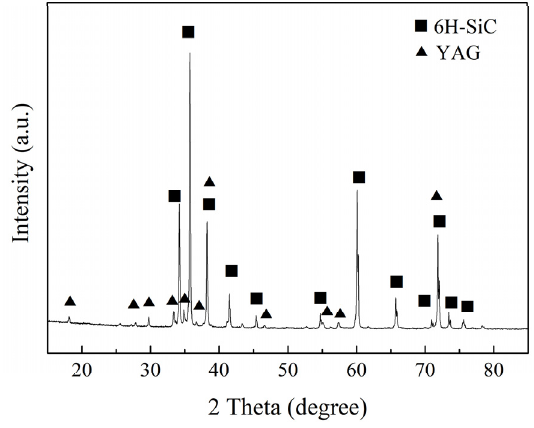
Figure 5. The X-ray spectrum of the sintered laminated SiC ceramics.